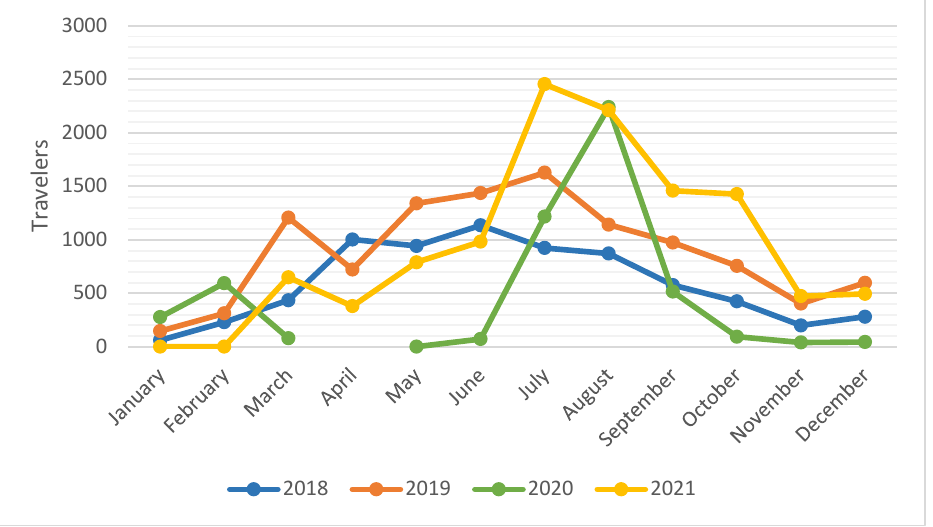
Figure 13. Graph of the evolution of international travelers for the years 2018, 2019, 2020 and 2021. Analyzing travelers according to the accommodation in which they stay overnight, hotel establishments receive the most travelers (56,345 in 2019 and 24,602 in 2020), followed by rural accommodations (52,960 in 2019 and 22,395 in 2020) and campsites (42,523 in 2019 and 21,578 in 2020). There were lower values for tourist flats, which received almost 14,500 travelers in 2019 and slightly over 10,000 travelers during the pandemic. Finally, in the latter year, hostels did not even reach half of the number of travelers received in 2019.